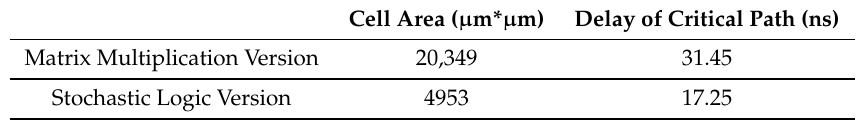
Table 2. Comparison results between stochastic logic version and matrix multiplication version.